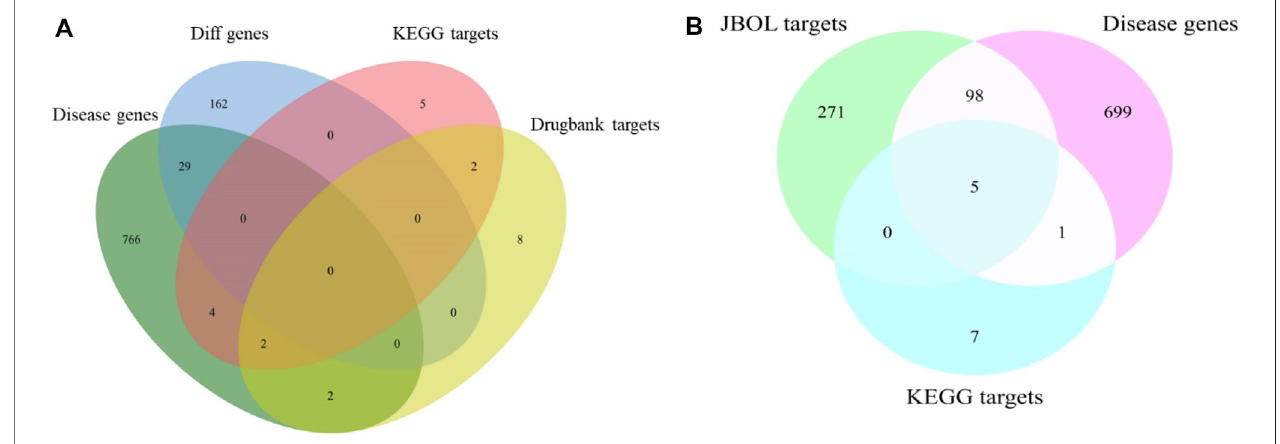
FIGURE 3 | Overlap of the target genes between IPF and JBOL. (A) Matching for the IPF genes, KEGG, and drug bank genes. (B) Matching for the IPF genes, KEGG drug target genes, and JBOL target genes.